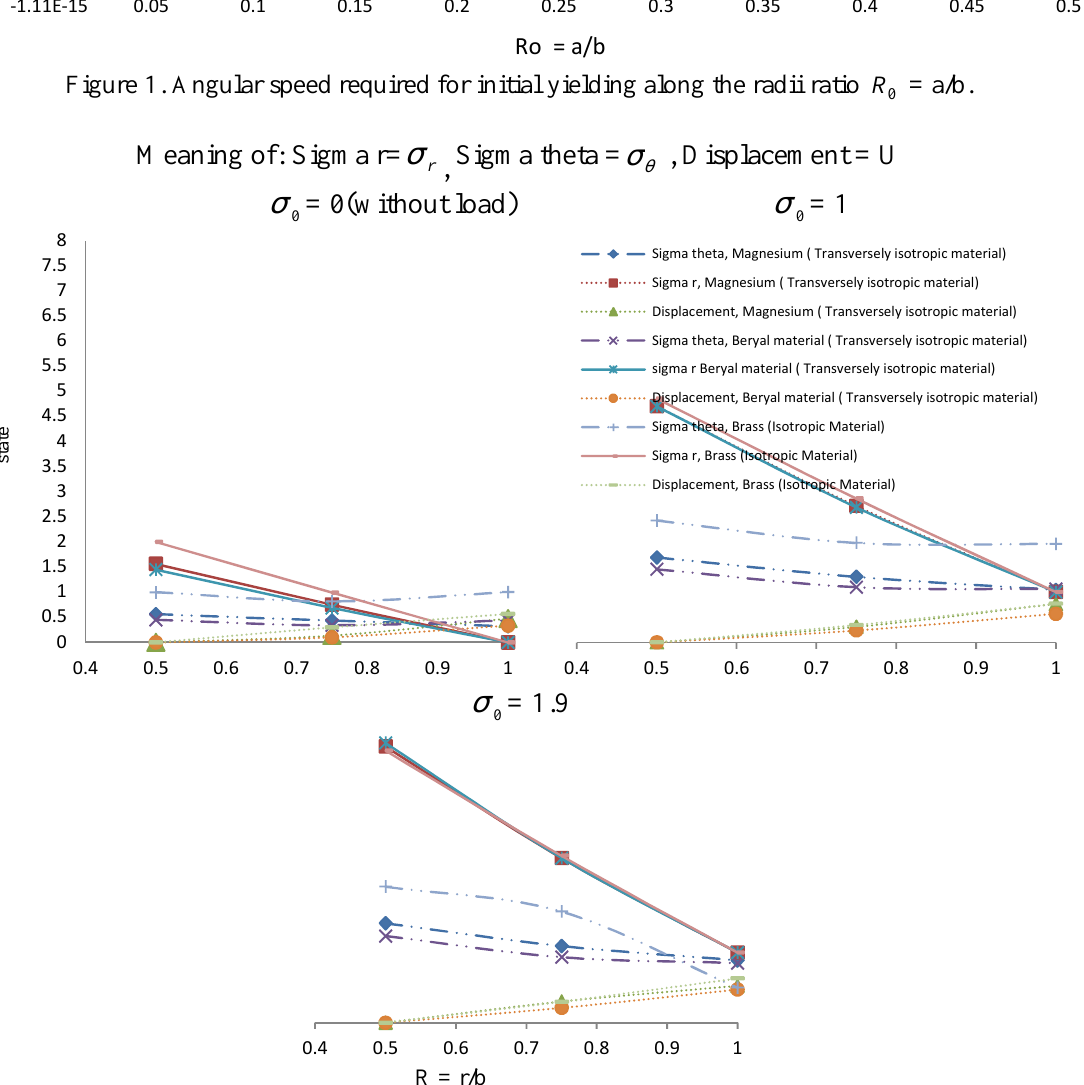
Figure 2. Stresses distribution and displacement for initial yielding along the radius ratio R =